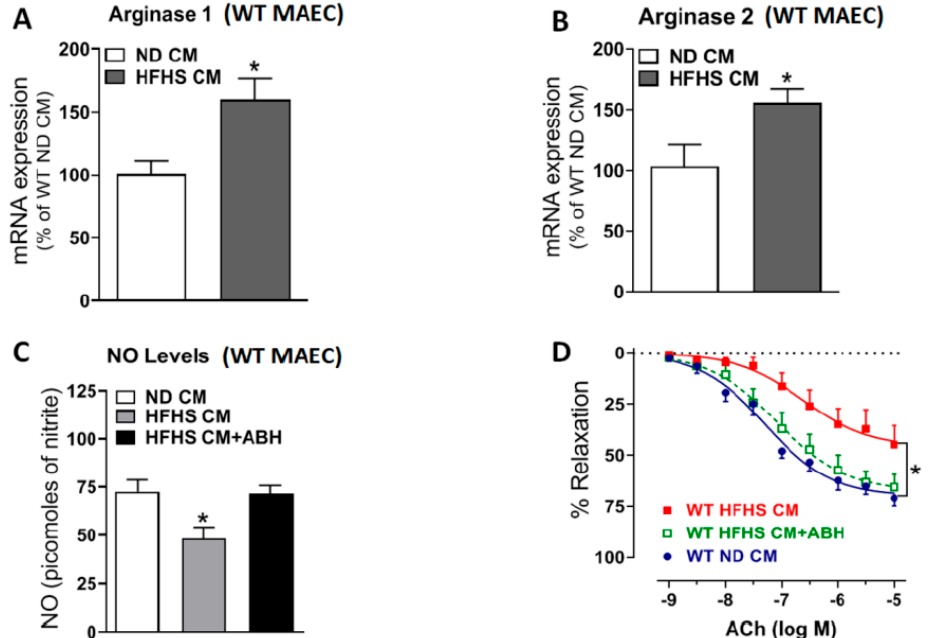
Figure 9. Vascular endothelial dysfunction induced by conditioned medium (CM) from VAT of WT-HFHS mice involves arginase upregulation. Conditioned media (CM) was prepared by incubating 50 mg VAT from either WT-ND or WT-HFHS mice for 24 h in M199 media. Presented are mRNA expression of A1 ( A ), A2 ( B ), and NO production ( C ) in MAEC. Additionally presented are endothelial-dependent vasorelaxant responses to acetylcholine in aortic rings from WT-ND mice treated for 24 h with CM from VAT of WT-ND and WT-HFHS mice in the presence/absence of ABH (100 µ M) ( D ). Values are mean ± SEM. * P < 0.05 vs. WT-ND CM, # P < 0.05 vs. WT-HFHS CM (n = 4–5).